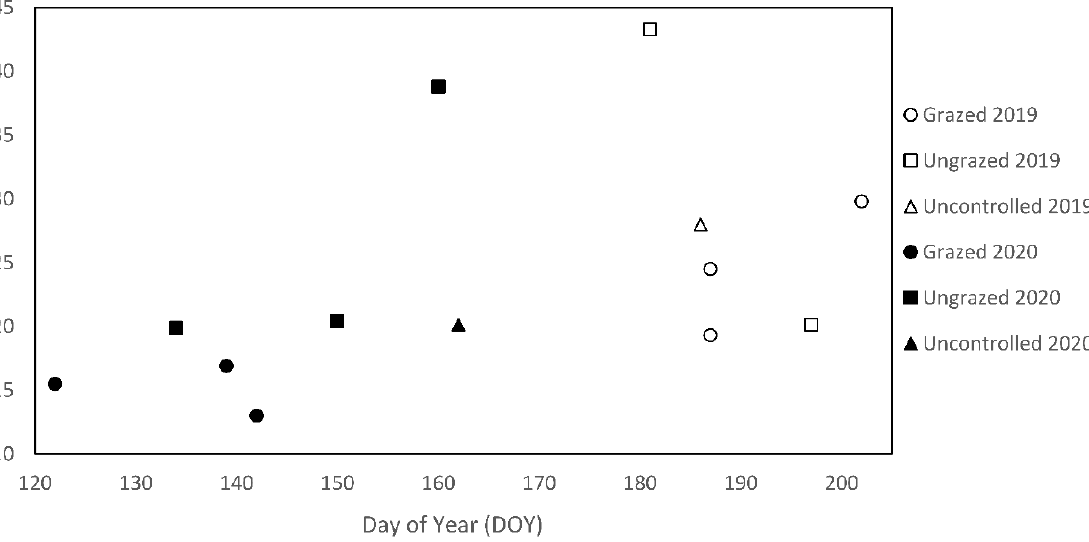
Figure 9. Average recession dates (RD) in relation to their soil volumetric water content (%) values for grazed, ungrazed, and uncontrolled meadows. It should be noted that in 2019, all meadows were treated as uncontrolled. In 2020, grazing treatment actually began. Designating meadows as grazed, ungrazed, and uncontrolled in 2019 was done solely to show differences in the groups of meadows across the years.